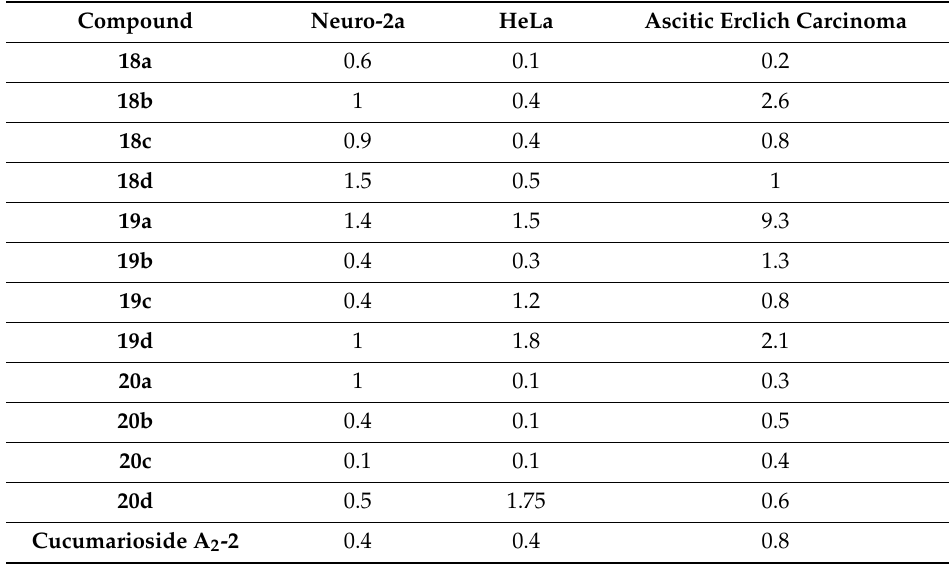
Table 2. Tumor cell selectivity (Selectivity Index (SI)) of tested tetracycles 18a – d – 20a – d .